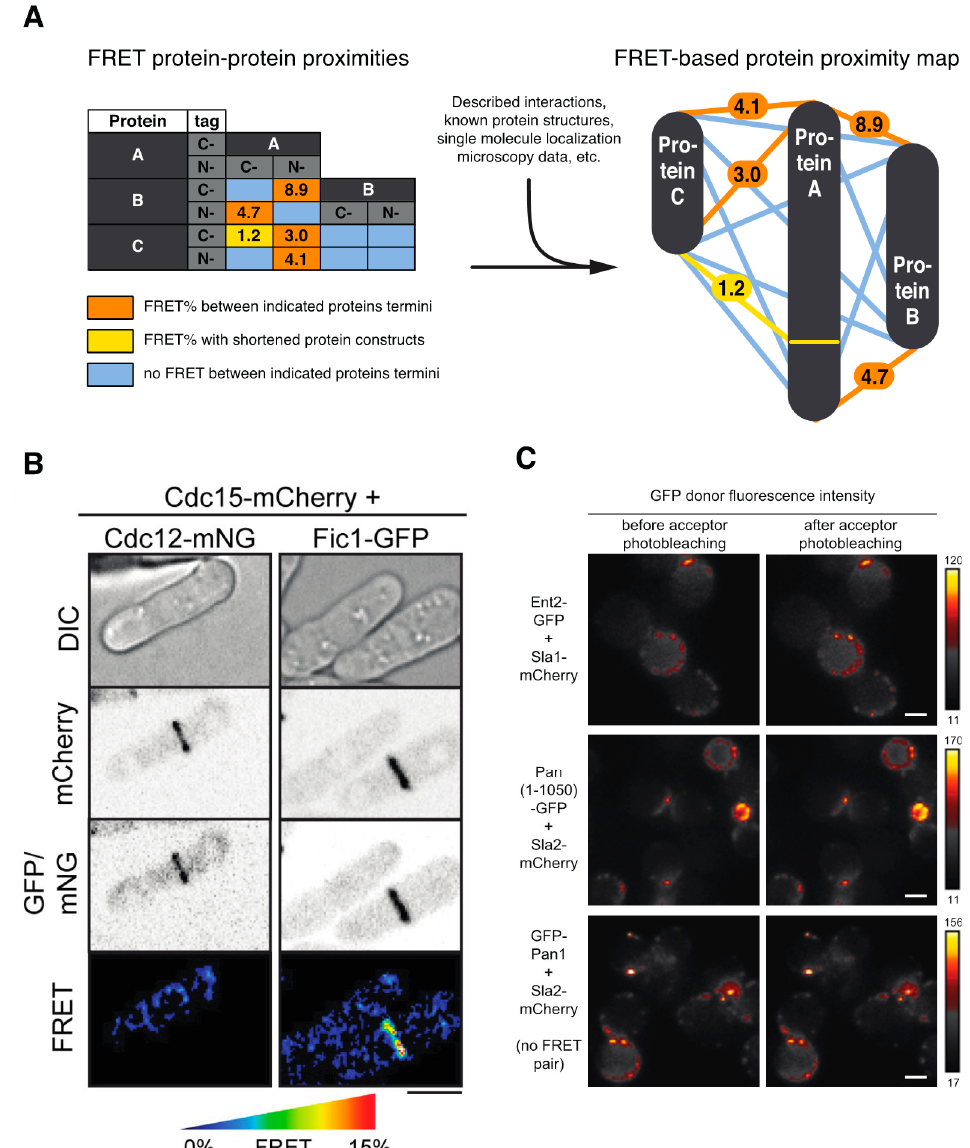
Figure 2. Mapping the organization of yeast protein complexes with FRET. ( A ) General scheme of FRET-based protein proximity mapping between proteins A, B, and C, tagged with fluorescent proteins (FPs) either N- or C-terminally. ( B ) No FRET and FRET between indicated FP-fusion proteins of Schizosaccharomyces pombe cell division contractile ring. See [21] for further details. ( C ) FRET between indicated FP-fusion proteins of Saccharomyces cerevisiae endocytic coat complex is shown as an increase of green fluorescent protein (GFP) donor fluorescence intensity after mCherry acceptor photobleaching. See [22] for further details. ( A , C ) Images adopted from [22]; ( B ) image taken from Figure 5 of [21]. Scale bars: 4 μ m (B), 2 μ m ( C ).